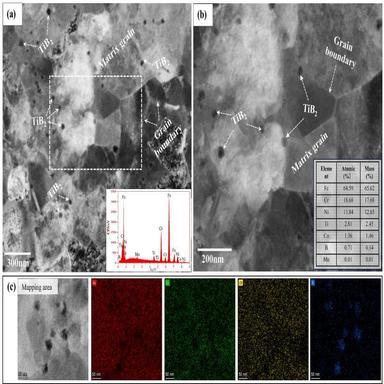
(a) Low-magnification TEM image of stainless-steel nanocomposite doped with 2.5 vol% of TiB2 nanoparticles and (b) its enlarged image in the marked region in Fig. 7(a) and (c) EDS mapping showing major elemental phases with their quantitative analysis.